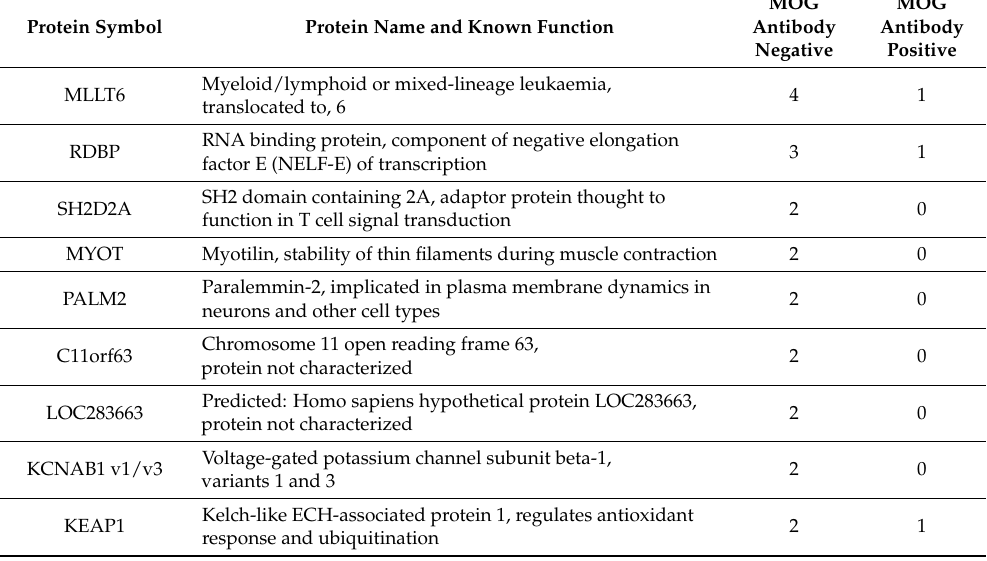
Figure 2. MOG antibody seropositivity does not significantly influence z-scores in paediatric patients with ADEM. Z-scores of candidate proteins (Y-axis) that exceeded the cut-off (2.33) in at least two patients per group are shown (for more details see Table 1). Means are indicated by the bars. The cut-off is shown as a dashed horizontal line. No significant differences were observed (matched two-way ANOVA). MLLT6: Myeloid/lymphoid or mixed-lineage leukaemia, translocated to, 6; RDBP: Negative elongation factor E (NELF-E); MYOT: Myotilin; PALM2: Paralemmin-2; C11orf63: Chromosome 11 open reading frame 63; LOC283663: hypothetical protein LOC283663; KCNAB1-1/3: Voltage-gated potassium channel subunit beta-1, variants 1 and 3; KEAP1: Kelch-like ECH-associated protein 1. Table 1. Protein sequences with z-scores ≥ 2.33 in at least two patients within the myelin oligodendrocyte glycoprotein (MOG) antibody negative patient group. Listed proteins were shown to be autoantibody target in at least two samples per group; protein reactivity of only one patient per group was not included in this list. Source: uniprot.org.